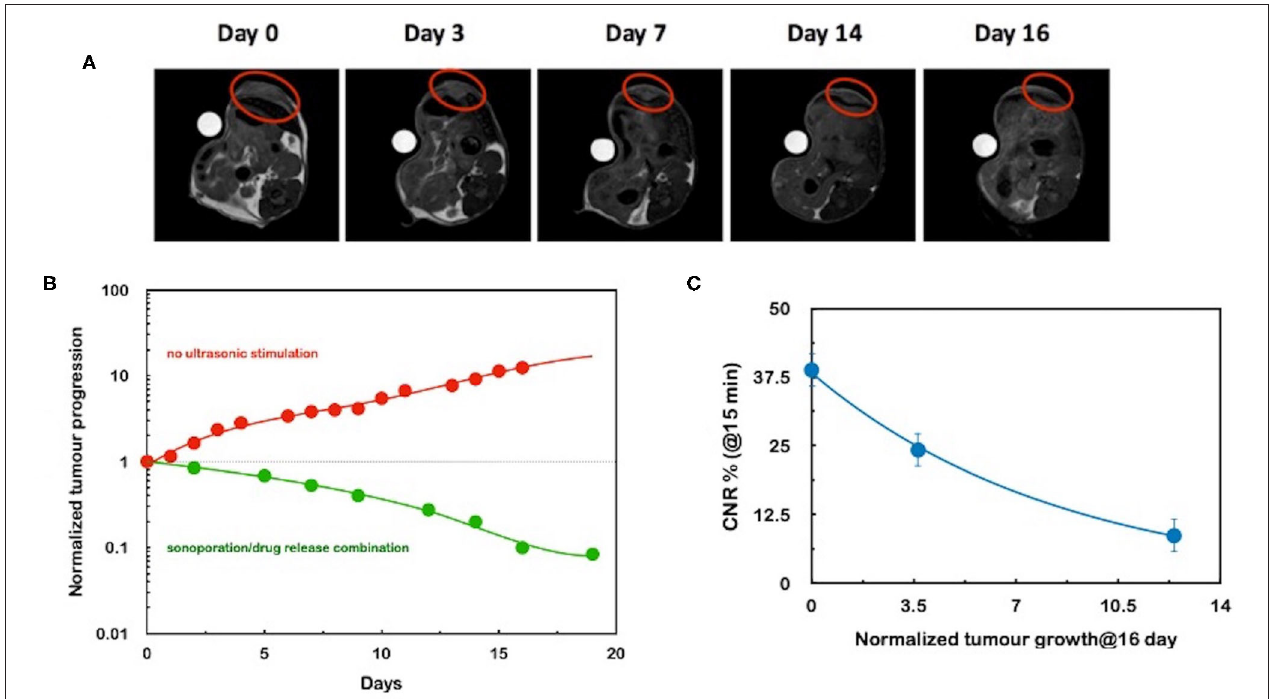
FIGURE 2 | (A) series of morphological MR images acquired at different days after the administration of sonosensitive gadoteridol- and doxorubicin-loaded MRI-detectable liposomes. The red circle indicates the tumor. The stimulation of the tumor with a combination of acoustic waves for inducing sonoporation and triggering drug release led to an almost full regression of the lesion. Lines represent an interpolation of the data for eye-guiding purposes. (B) Time evolution of the tumor volume, normalized to the value at day 0. It is noteworthy that the red data refer to the nanomedicine very close to the clinically approved formulation. (C) Correlation between the MRI T 1 contrast-to-noise ratio (CNR%) measured just after the first US stimulation at day 1 and the normalized tumor volume at day 16 for three experiments. The line is an interpolation of the data for eye-guiding purposes. This plot represents the experimental counterpart of the scheme illustrated in Figure 1 . Adapted from ref.